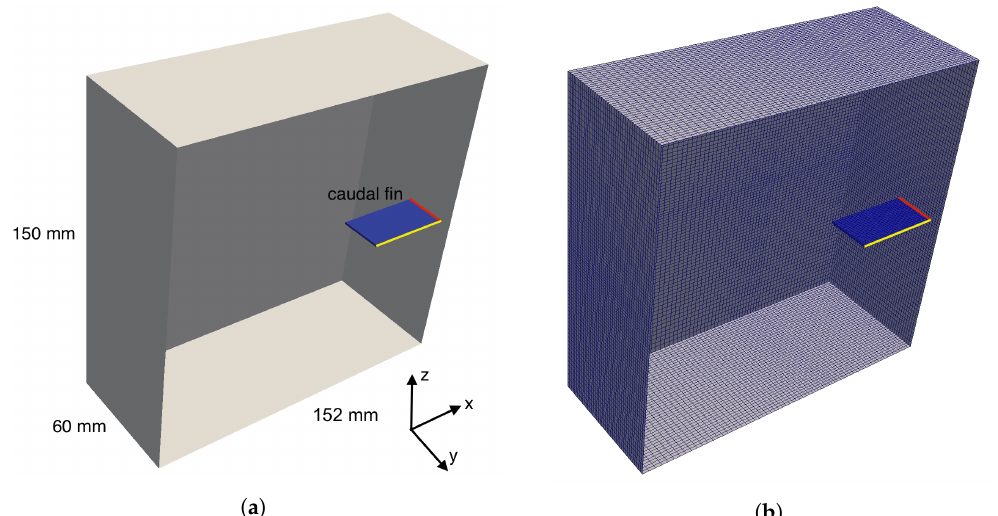
Figure 2. ( a ) Schematic view of a computational domain. ( b ) Grid generation. The leading edge and symmetry plane of the plate are indicated by red and yellow lines, respectively. The origin of coordinate is at the center of the leading edge of the